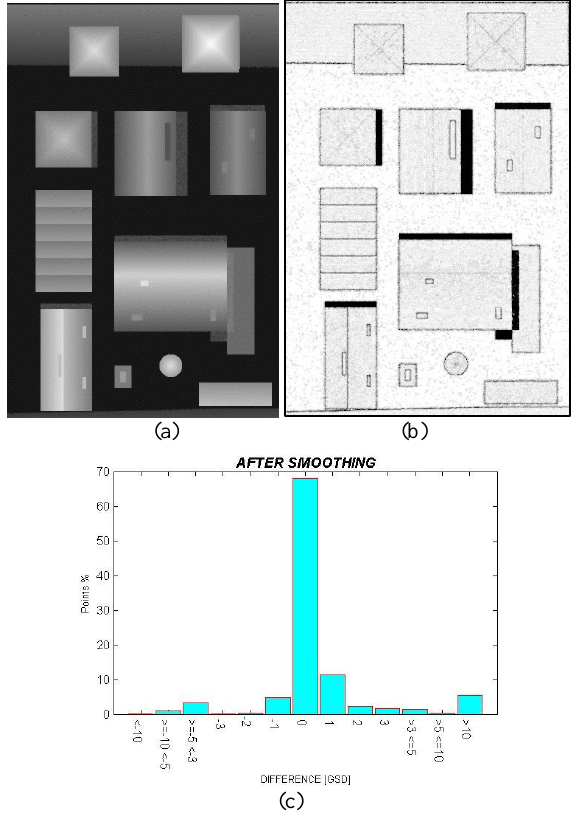
Figure 6: denoised DSM (a), differences between ground truth and the smoothed DSM using the TGV regularization filter (b) and histogram of the differences